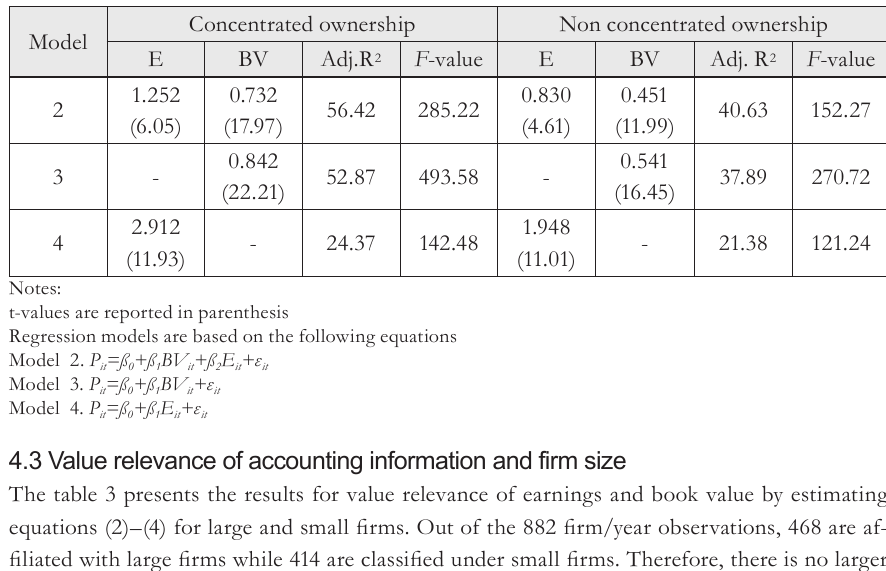
Tab. 2 - Value relevance of earnings and book value with ownership concentration.